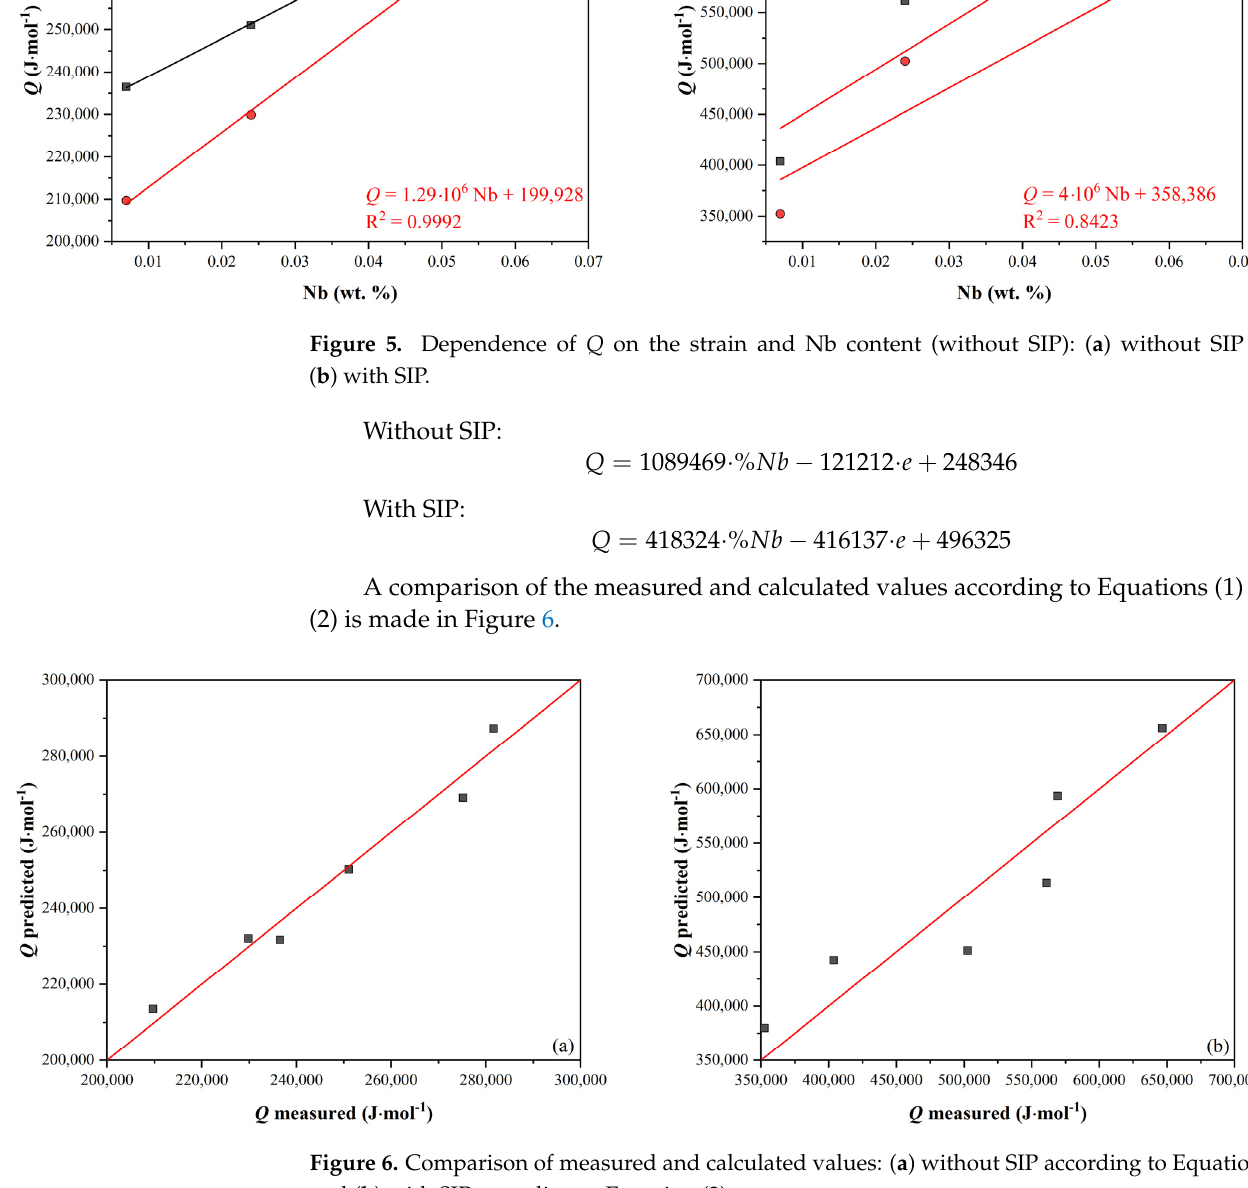
Figure 6. Comparison of measured and calculated values: ( a ) without SIP according to Equation (1 and ( b ) with SIP according to Equation (2).